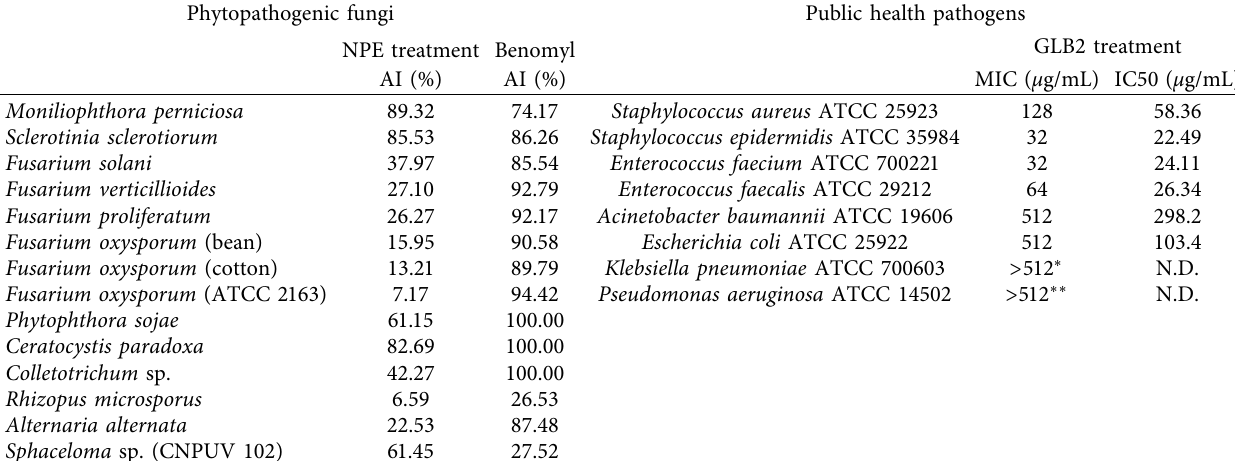
Table 5: Antagonistic activity of B. cepacia strain COPS NPE toward phytopathogenic fungi and pathogenic